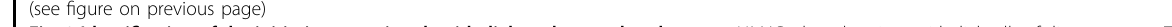
Fig. 2 Identi fi cation of the initiation-associated epithelial markers and pathways. a UMAP plots showing epithelial cells of diverse stages. Their proportions in C1 and C2 clusters were circled in the map and the statistics were shown in bar plot. b Statistical results showing CNV-meanSquare of epithelial cells at different initiation stages. Endothelial cells and fi broblasts as a whole represented the baseline reference. Nonparametric unpaired t- tests were used to calculate the statistical signi fi cance. *** P < 0.001. c Characterization of OSCC initiation process with ST feature plots from P6 showing cancer-related pathways (Top). Changes of these pathways ’ activities in patients of ST. Each dot indicated the median of the pathway activity in the corresponding N, DN or T region (Bottom). d Enriched GO functions of DEGs with gradual-increased expression among epithelial cells from N, DN, and T stages. FDR q value < 0.05. e Changes of FRA pathway activities along with tumor initiation process in ST. Each dot indicated the median of the pathway activity in the corresponding region. f Dotplots showing the signi fi cance ( − log10 P value) and strength (mean value) of speci fi c interactions between T, Myeloid, and cancer-associated fi broblast (CAF) cells with epithelial cells at N, DN, and T stages. Signi fi cant mean and signi fi cance ( P < 0.05) were calculated based on the interaction and the normalized cell matrix was achieved by Seurat Normalization. g Heatmap of DEGs between epithelial cells of diverse initiation stages. The eight genes con fi rmed by ST were marked red. h Heatmap for statistical analyses of 8 initiation-associated genes expression in ST feature plots (each row shared a color scale, while different columns did not). i Statistical analysis of the eight initiation-associated genes expression in fi ve ST feature plots. The dot plots display statistical score values for theses eight-gene sets in each region of tissue sections. A two-tailed paired Student ’ s t- test for the P values. * P < 0.05. j Spatial feature plots of TFAP2A in tissue sections of P6. k Statistical results showing proportions of TFAP2A positive points in different tissue regions by ST analyses. l The gene-expression levels of TFAP2A in siTFAP2A and siNC group. Data were presented as the mean ± s.d. NC control group. m Quanti fi cation of EdU-positive cell proportions in siTFAP2A groups. Four representative pictures of each group were used for quanti fi cation. A two-tailed unpaired Student ’ s t -test for the P values in l , m . * P < 0.05; *** P <